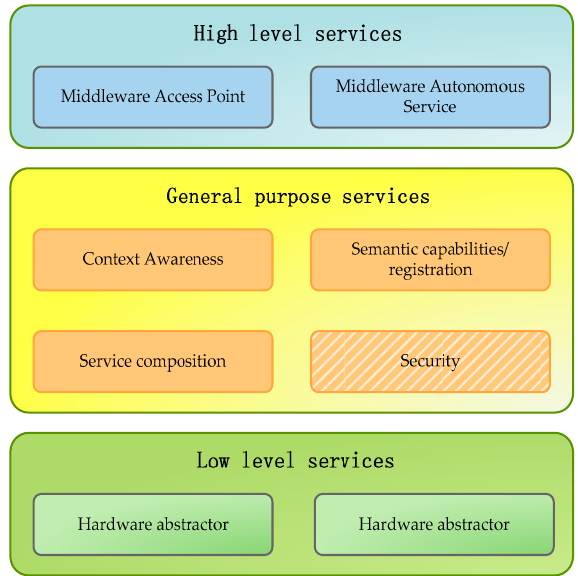
Figure 3. Components of the common middleware architecture [42].